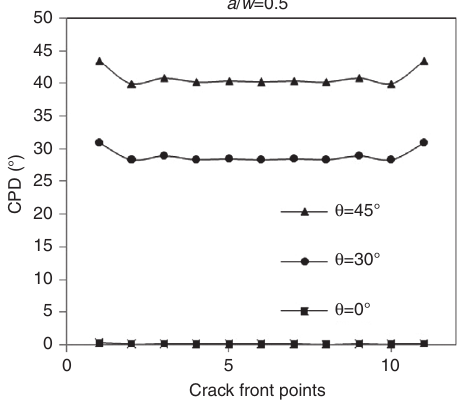
Figure 13 CPD in different crack angles.